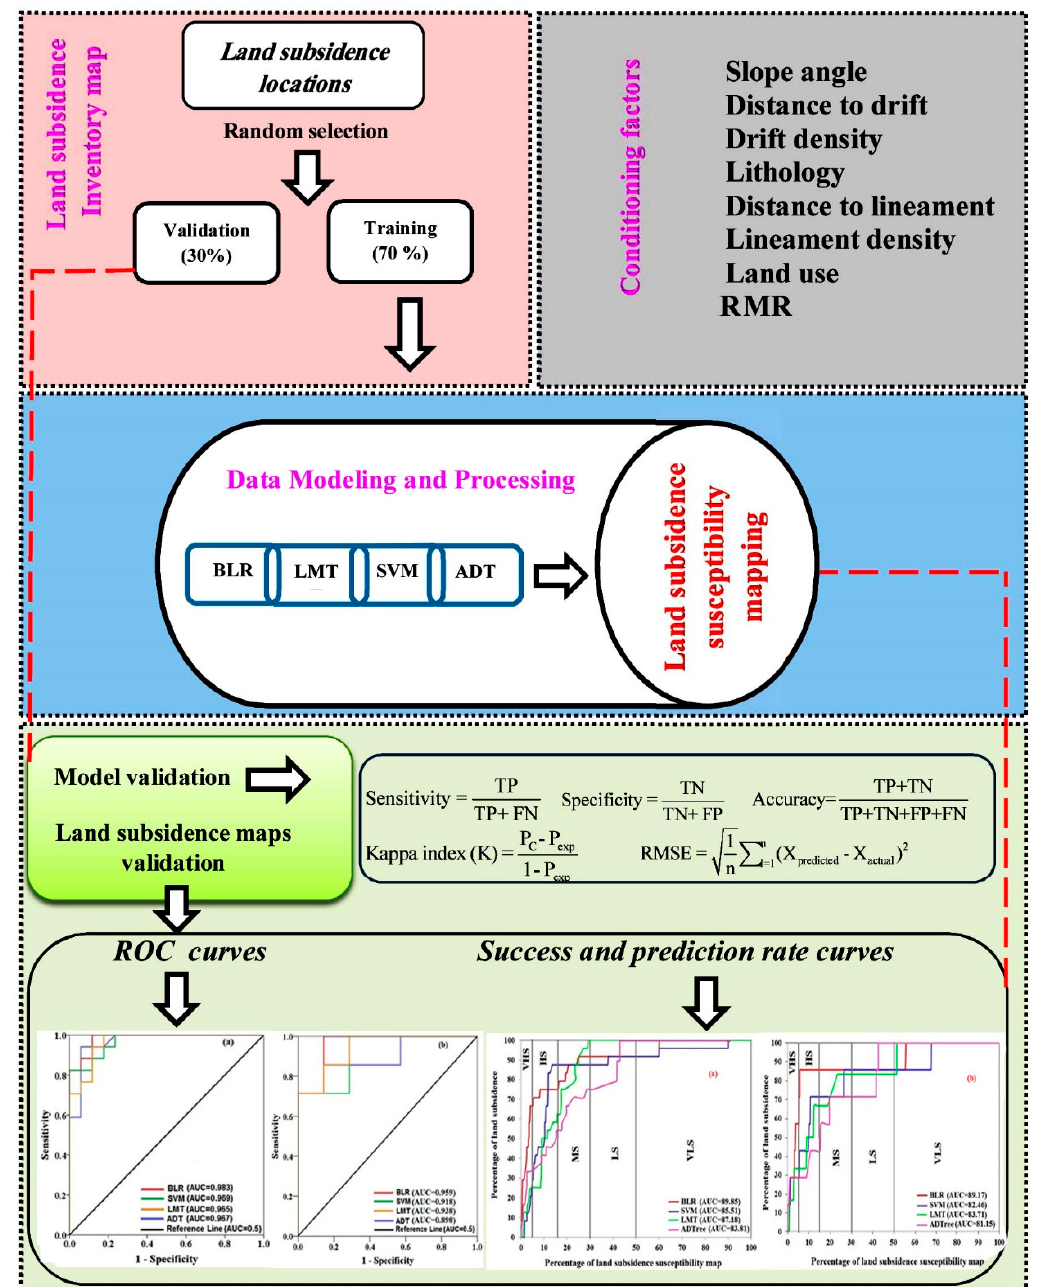
Figure 2. The flowchart of land subsidence modelling process in the study area.